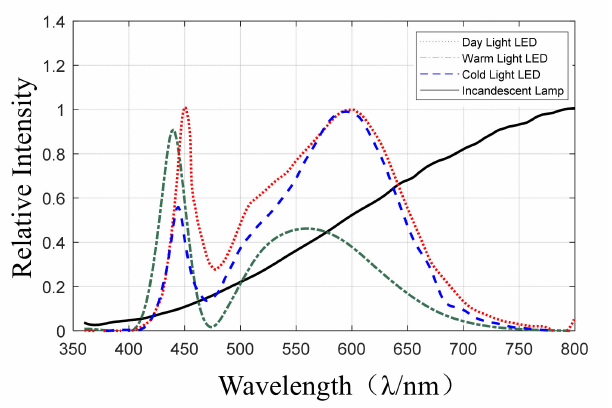
Figure 3. The spectral component curves of different